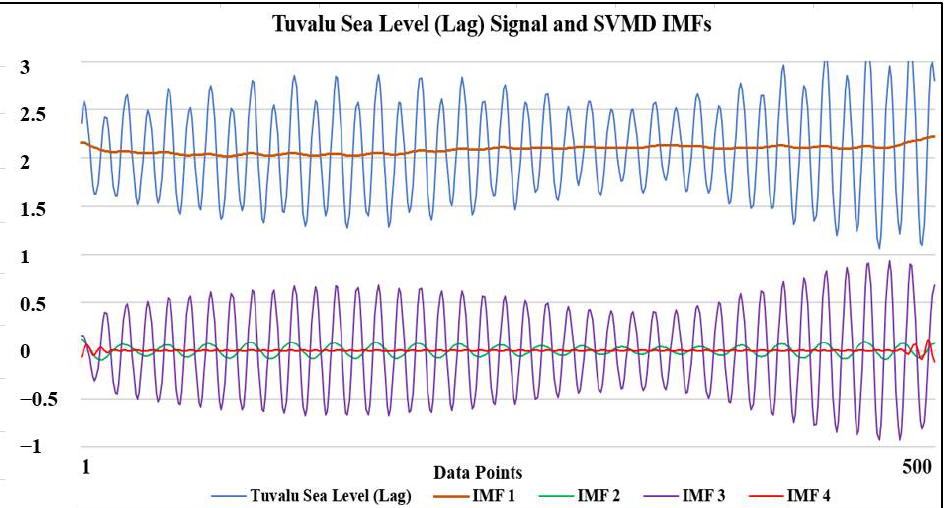
Figure 6. SVMD mode decomposition of Tuvalu sea level (lag) signal into its IMFs for 500 data points.